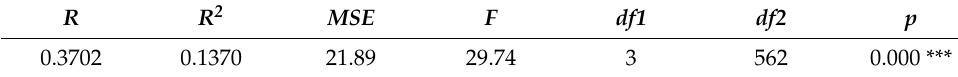
Figure 2. Regression plot of ( a ) self-compassion and happiness and ( b ) empathy and happiness. Table 3. Self-Compassion as a moderator between empathy and happiness ( N = 566).